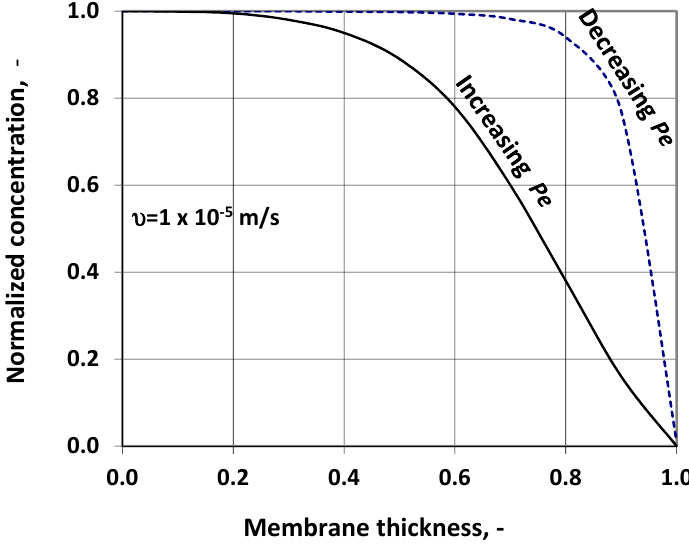
Figure 2. Illustration of the concentration distribution, during di ff usive plus convective mass transfer with a variable di ff usion coe ffi cient and constant convective velocity, predicted by expressions given in Figure 3. Illustration of the concentration distribution, during diffusive plus convective mass transfer Section 2.3. ( D o = 1 × 10 − 9 m 2 / s; δ = 5 × 10 − 4 m; υ = 1 × 10 − 5 m / s; N = 30; φ with a variable diffusion coefficient and constant convective velocity, predicted by expressions given or Pe i = ( 5 − 0.15 i )